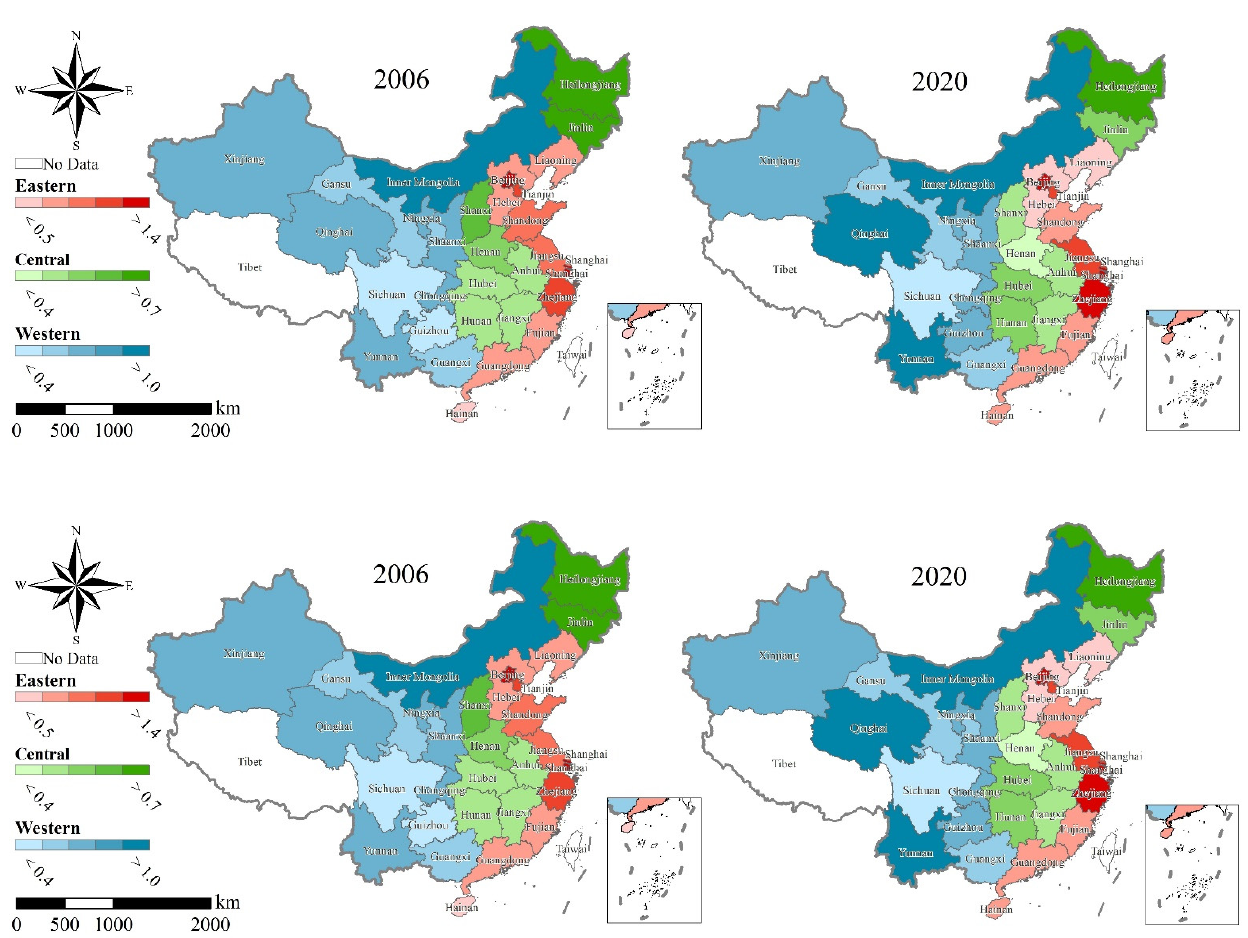
Figure 1. Livelihood resilience of rural residents in China by province in 2006 and 2020. Source: the authors’ own